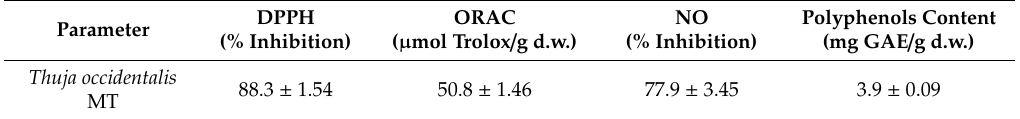
Table 1. Evaluation of the antioxidant capacity of Thuja occidentalis MT.